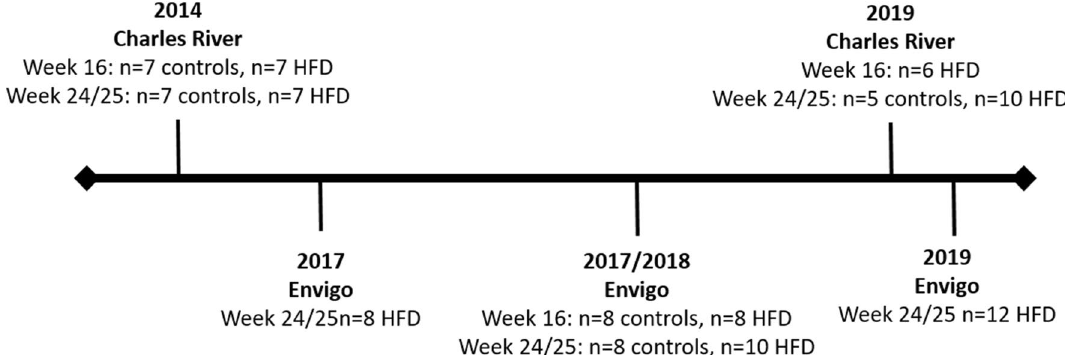
Figure 6. Overview of included studies. This retrospective analysis included animals from five different studies conducted from 2014 to 2019. Studies were not executed sequentially e.g. with animals from one breeder at the start and animals from the other breeder at the end of the time period, minimizing the risk of